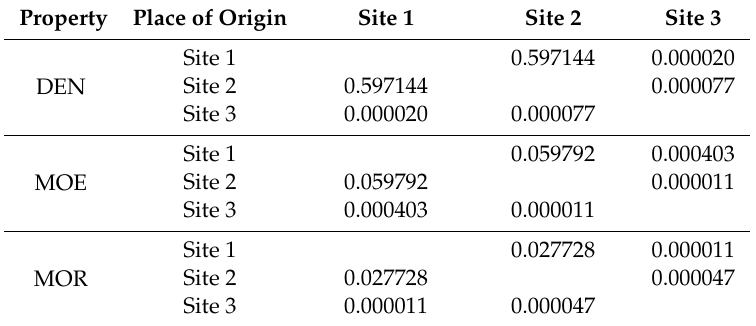
Table 5. Probability of post-hoc tests for log geographical origin as the di ff erentiating